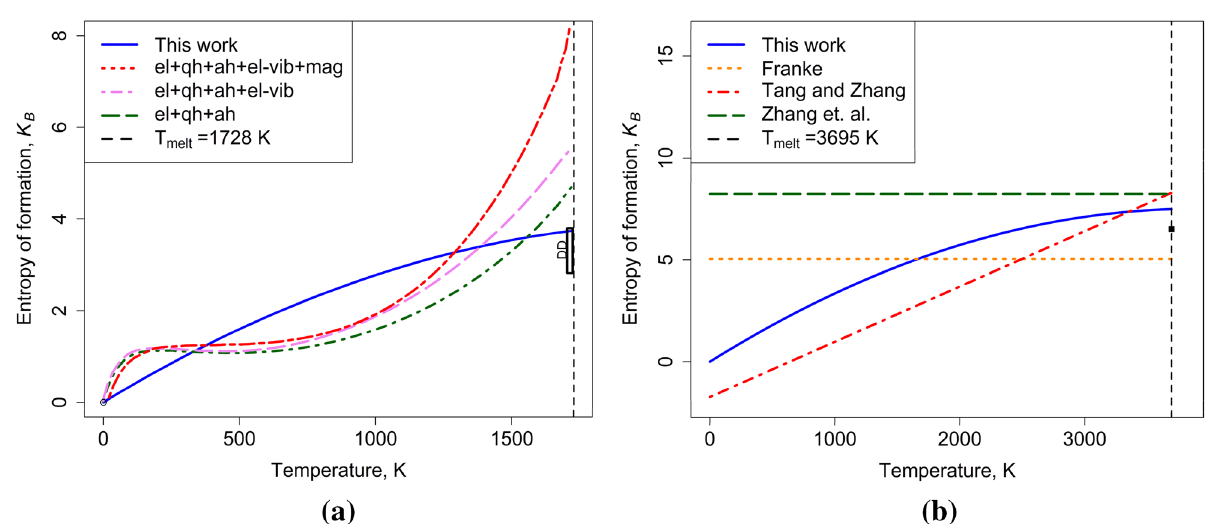
Figure 9. Entropy of vacancy formation for Ni and W, comparing the model performance for ( a ) FCC-Ni against experimental data 57 and atomistic simulations 31 ( b ) BCC-W against experimental data 6 and Calphad models of Franke 20 , Tang and Zhang 21 , and Zhang 17